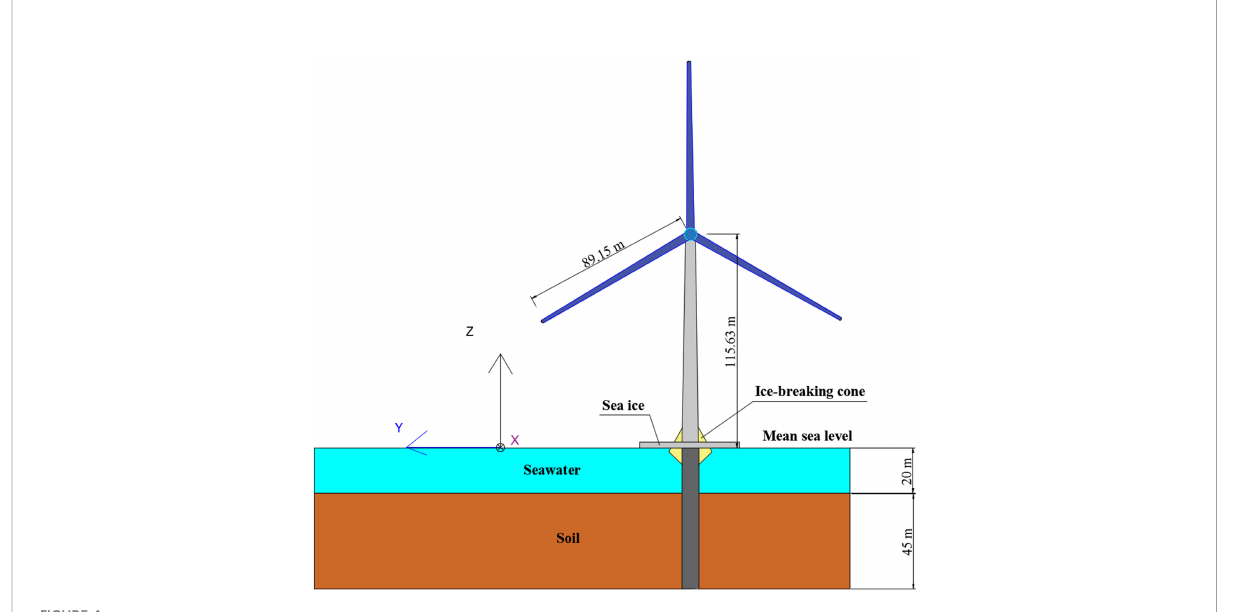
FIGURE 4 Schematic diagrams of the DTU 10 MW OWT (Velarde and Bachynski,